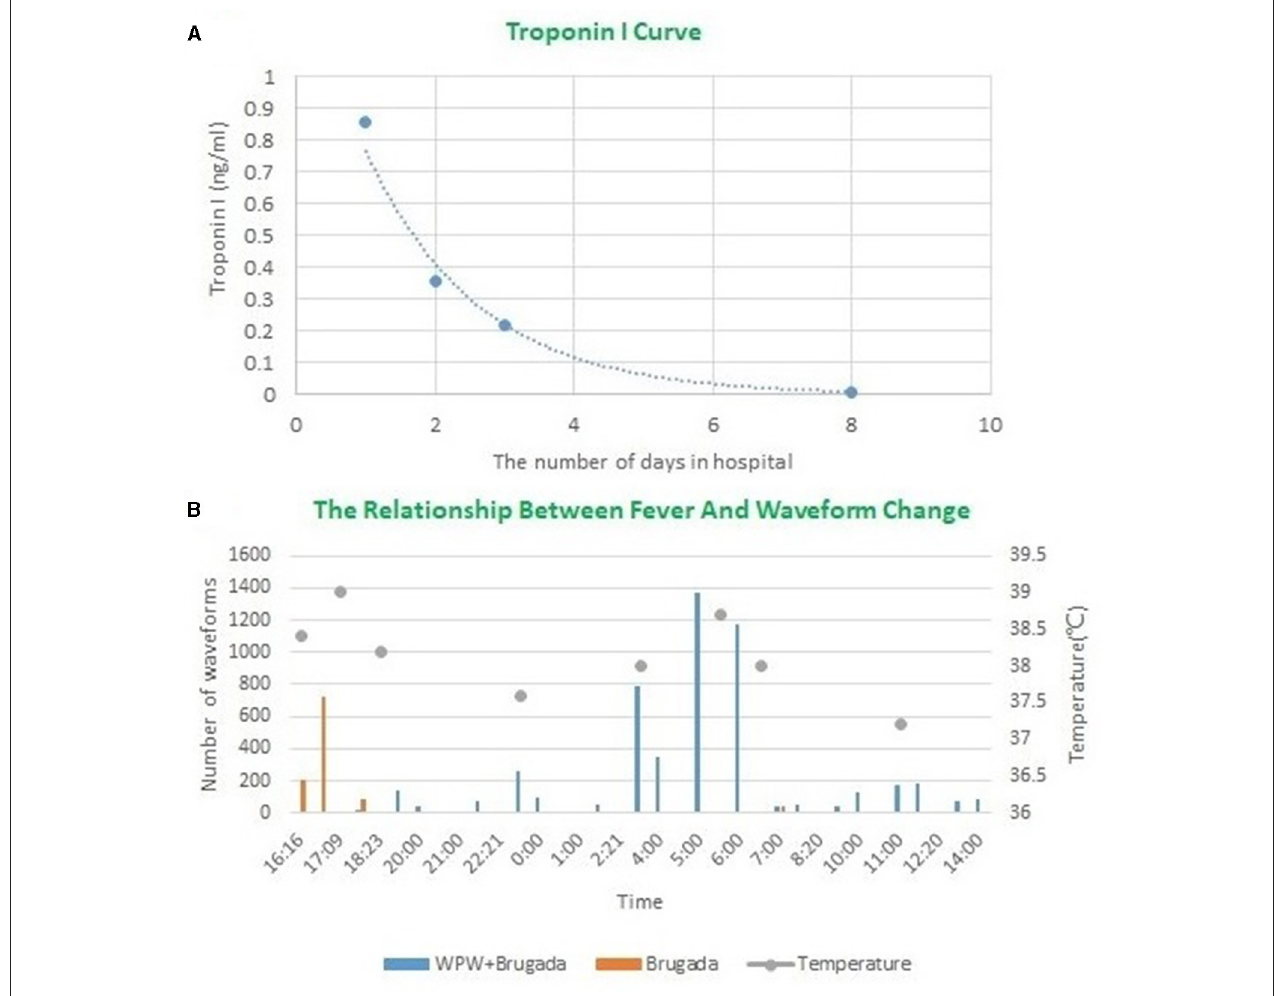
FIGURE 3 | (A) The change curve of troponin I during hospitalization. (B) The relationship between fever and waveform changes during 24h Hortor monitoring period on the second day of admission. The orange mark represents Figure 1C . The blue mark represents Figure 2C